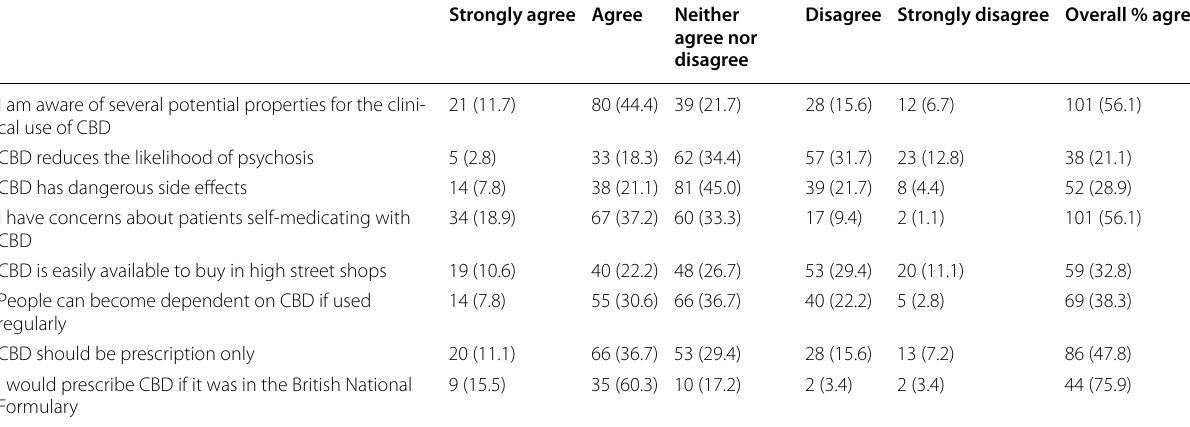
180). Please note that values represent frequencies =